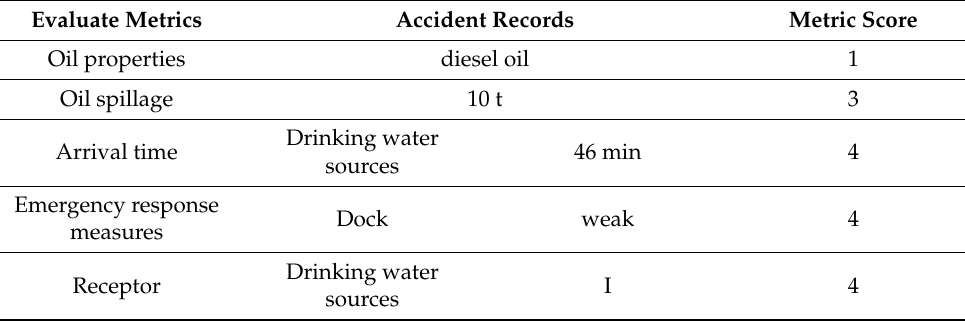
Table 11. Scores of accident risk